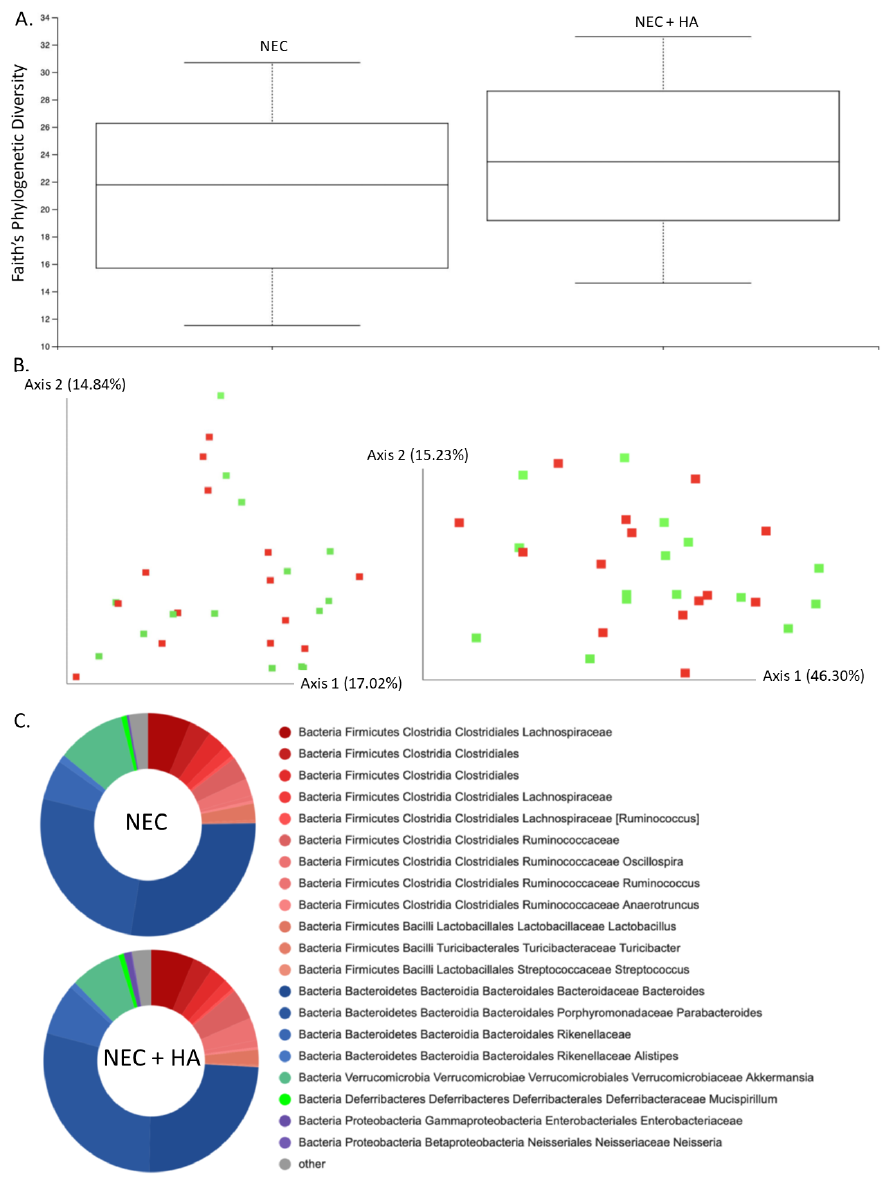
Figure 2. Cecal microbiome composition analysis comparing NEC and NEC + HA pups. ( A ) Faith’s phylogenetic diversity metric representing species richness within mouse pup microbiomes differentiated by treatment ( n = 29; Kruskal–Wallis p = 0.295). ( B ) PCoA plot of Bray–Curtis ( left ) and Weighted Unifrac ( right ) beta diversity matrices (NEC = red, NEC + HA = green). Percentage confidence values for each distance matrix displayed on axes in two dimensions (PERMANOVA: F = 1.065 and p = 0.379 (Bray– Curtis); F = 0.589 and p = 0.641 (Weighted Unifrac). ( C ) Taxonomy plots using a naïve Bayes classifier trained on the most recent Greengenes 16S rRNA database, with ASV reads taxonomically classified and filtered for genera > 0.5% of total microbiome composition for any one sample. Genera falling below the 0.5% mark were placed in “other” (gray). NEC: necrotizing enterocolitis; HA: hyaluronic acid; PCoA: principal coordinates analysis; ASV: amplicon sequence